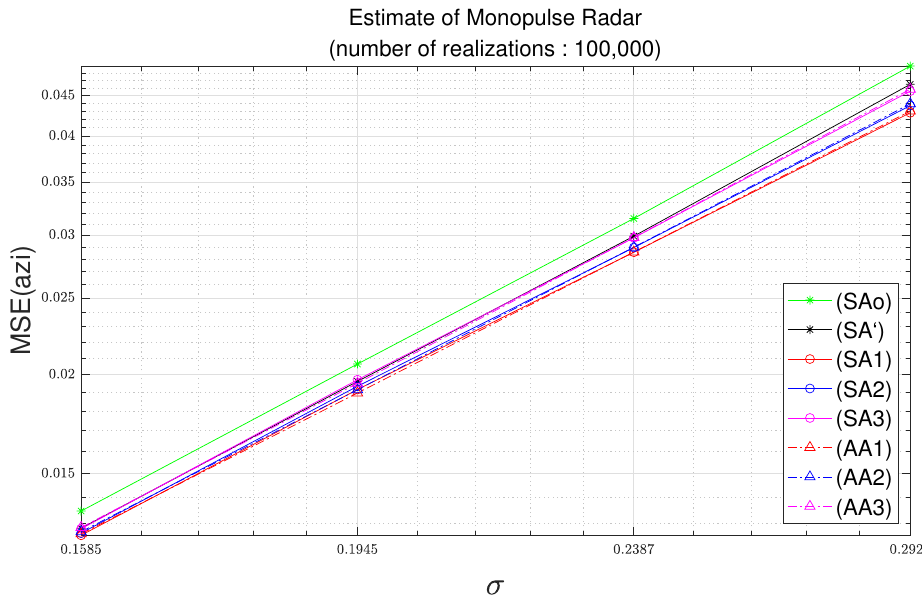
Figure 3. Azimuth MSE as function of standard deviation with parameters of Table 2 and 100,000 realizations.